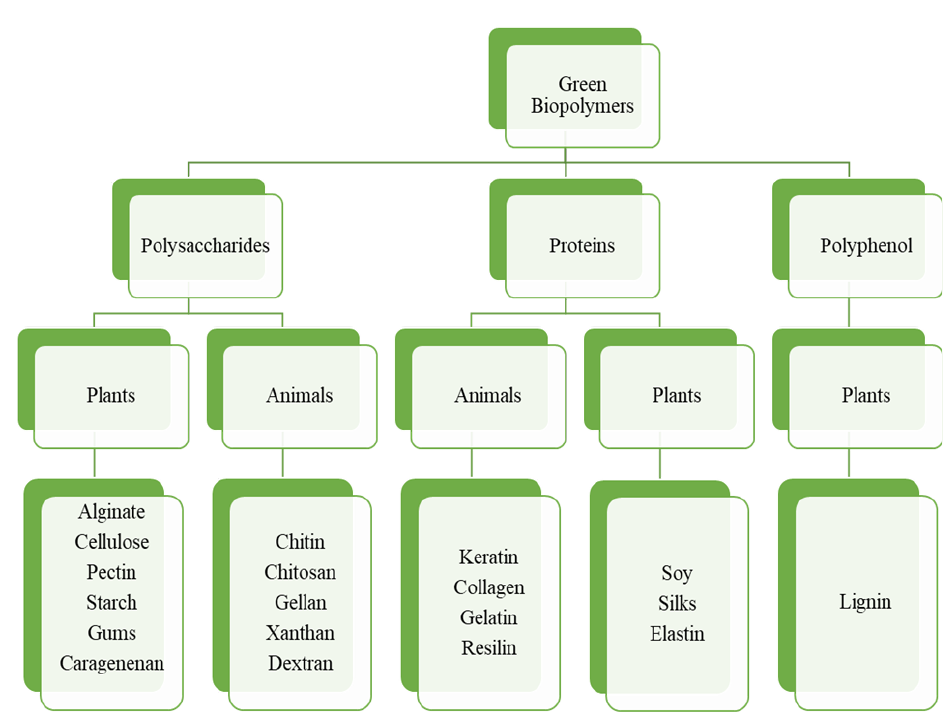
Figure 2. Classification of green biopolymeric materials.